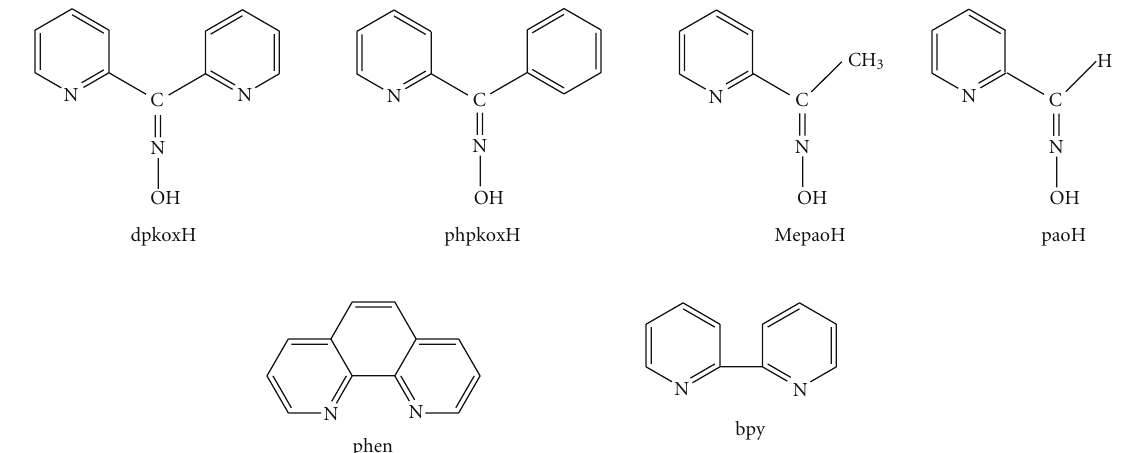
Figure 1: Structural formulae and abbreviations of the ligands discussed in the